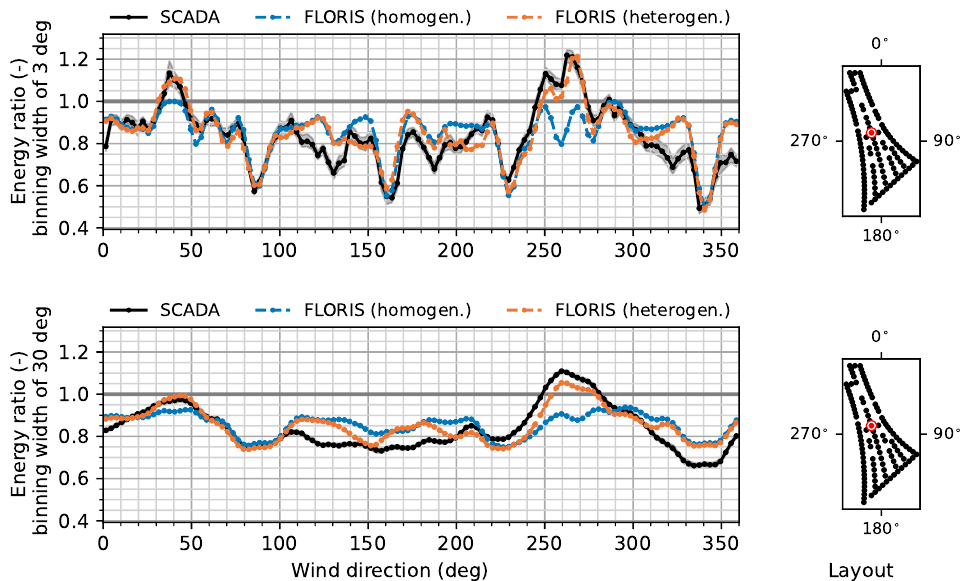
Figure 10. Energy ratio curves for Turbine 54 in the Anholt wind farm, in which the reference turbines are the five closest upstream turbines, and the reference wind direction is the average of the wind direction measurements of Turbines 40, 53, 56, and 100. The shaded regions represent 90% confidence intervals obtained through bootstrapping. The layout schematic on the right shows the location of Turbine 54 in the wind